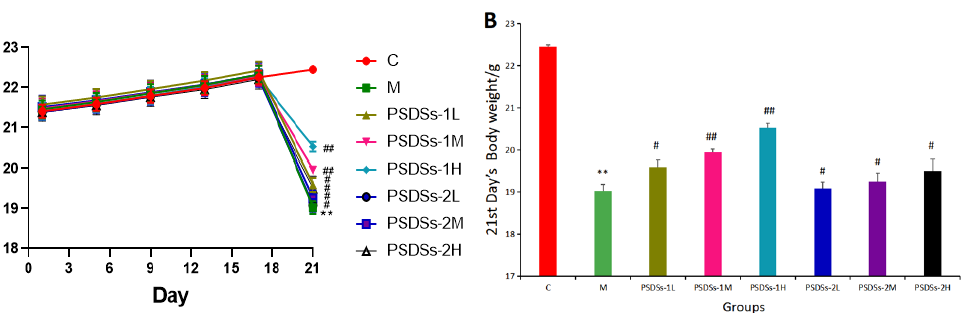
Figure 4. Effects of PSDSs of different Mw on the body weight of mice ( A ); Effects of PSDSs of different Mw on the 21st day body weight of mice ( B ). n = 8, x ± s. ** p < 0.01 vs. blank control group; # p < 0.05, ## p < 0.01 vs. model group.